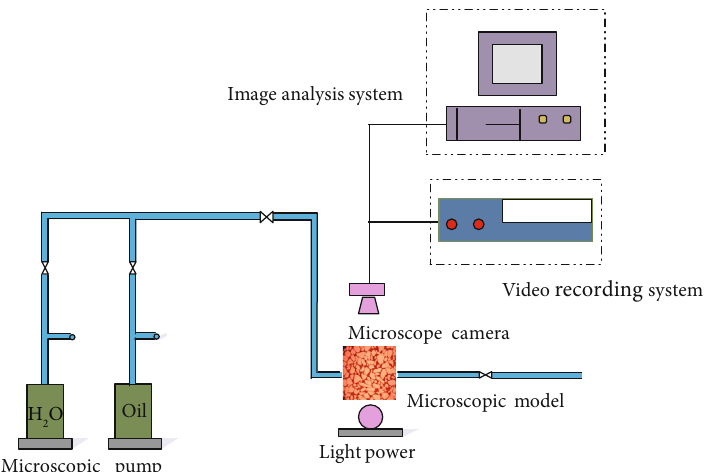
Figure 3: Flow chart of the glass model experiment.